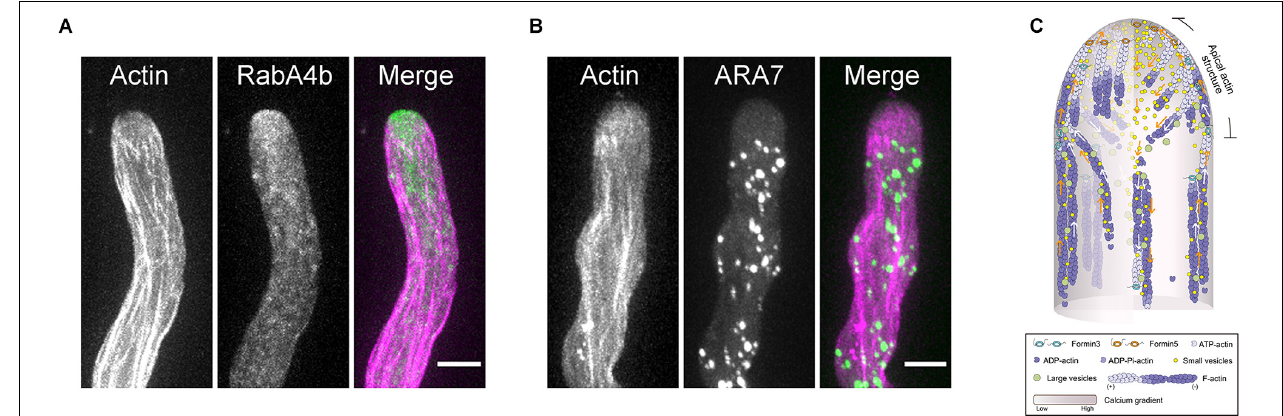
FIGURE 3 | The Role of the Actin Cytoskeleton in Regulating Vesicle Traffic in the Pollen Tube. (A) Dual visualization of RabA4b-positive transport vesicles (green) and actin filaments (pink) in a WT Arabidopsis pollen tube. The small RabA4b-positive transport vesicles accumulate at the pollen tube tip. Scale bar = 5 µ m. (B) Dual visualization of ARA7-positive endosomes (green) and actin filaments (pink) in a WT Arabidopsis pollen tube. The large ARA7-positive endosomes are absent at the pollen tube tip. Scale bar = 5 µ m. (C) Schematic depiction of the function of the actin cytoskeleton in regulating vesicle traffic in the pollen tube. Both ARA7-positive large endosomes and RabA4b-positive small vesicles are transported along cortical actin bundles in the shank region. Upon reaching the subapex, ARA7-positive large endosomes reverse their direction of movement and return to the base along the inner actin bundles. This is the basis for the generation of reverse fountain cytoplasmic streaming. However, after reaching the subapex, RabA4b-positive small vesicles run straight to the tip along cortical actin bundles within the “apical actin structure,” which leads to the accumulation of vesicles at the pollen tube tip. After reaching the extreme tip, some RabA4b-positive small vesicles will start to move toward the base of the pollen tube. The inner actin filaments within the “apical actin structure” function as physical barrier to prevent their return, which leads to the formation of the “V”-shaped distribution pattern of small